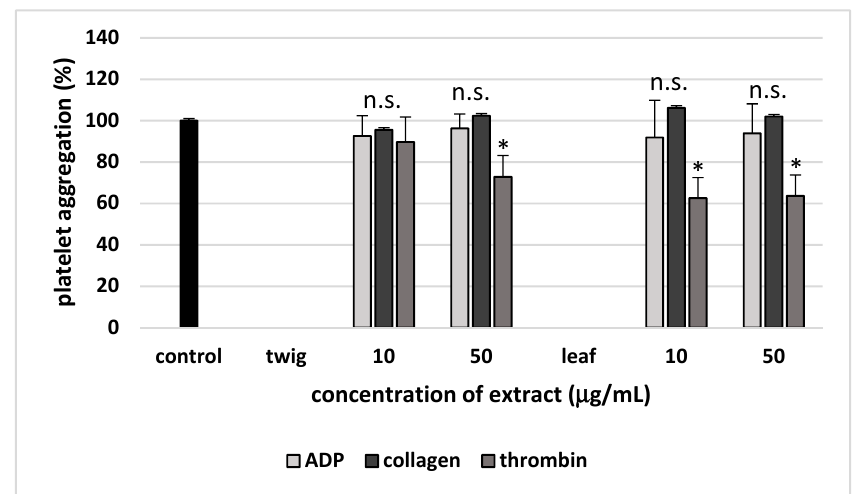
Figure 3. E ff ects of twig and leaf extract (10 and 50 µ g / mL; 30 min) on blood platelet aggregation stimulated by di ff erent agonists: 10 µ M ADP, 2 µ g / mL collagen and 1 Unit / mL thrombin. Data represent mean ± SE of 5 (for thrombin-activated platelets) and 9 (for ADP or collagen-activated platelets) healthy volunteers (each experiment performed in triplicate). Neither concentration of the tested extract (10 and 50 µ g / mL) had a statistically significant e ff ect on aggregation stimulated by ADP and collagen compared to control platelets ( p > 0.05 (n.s.)). However both concentrations of the tested extract (10 and 50 µ g / mL) had a statistically significant e ff ect on aggregation stimulated by thrombin compared to controls (* p < 0.05).